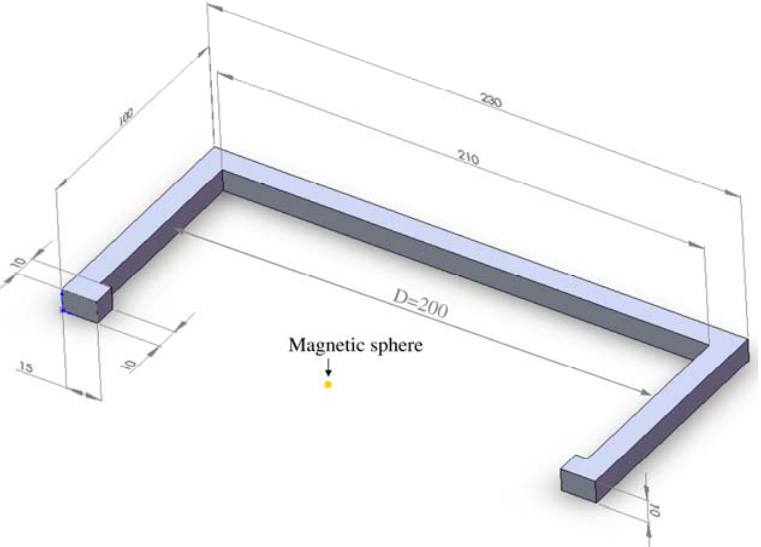
Figure 5. Overview of the dimension of the core for the C-coil.